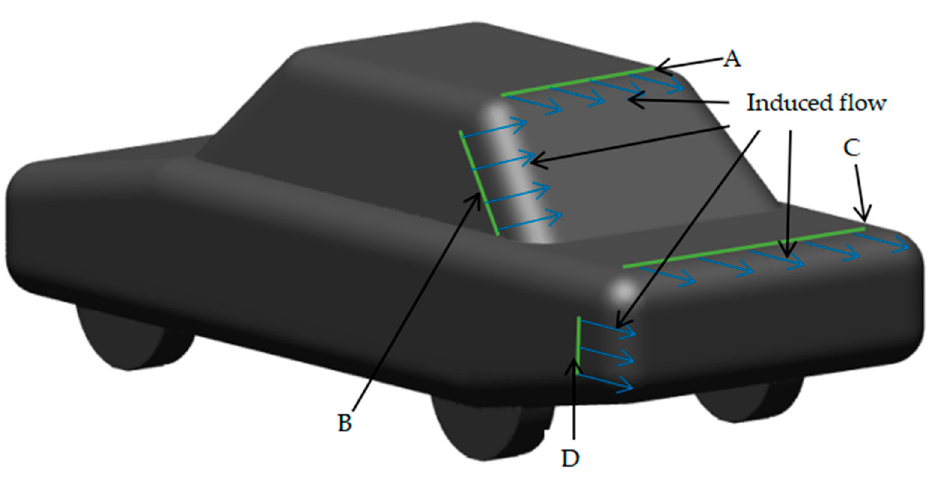
Figure 8. Schematic of the vehicle with the plasma actuator.